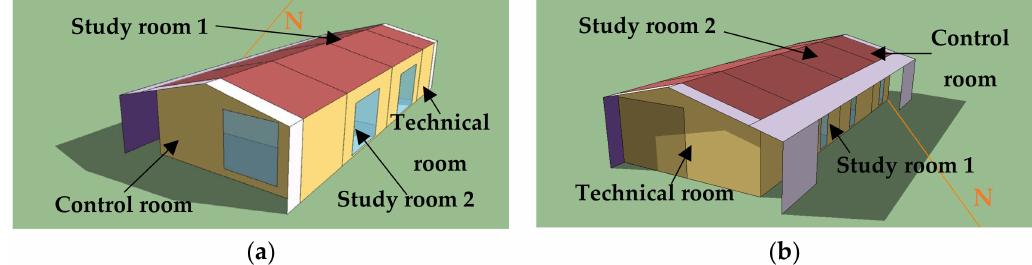
Figure 1. Facility layout seen from the South ( a ) and North ( b ).